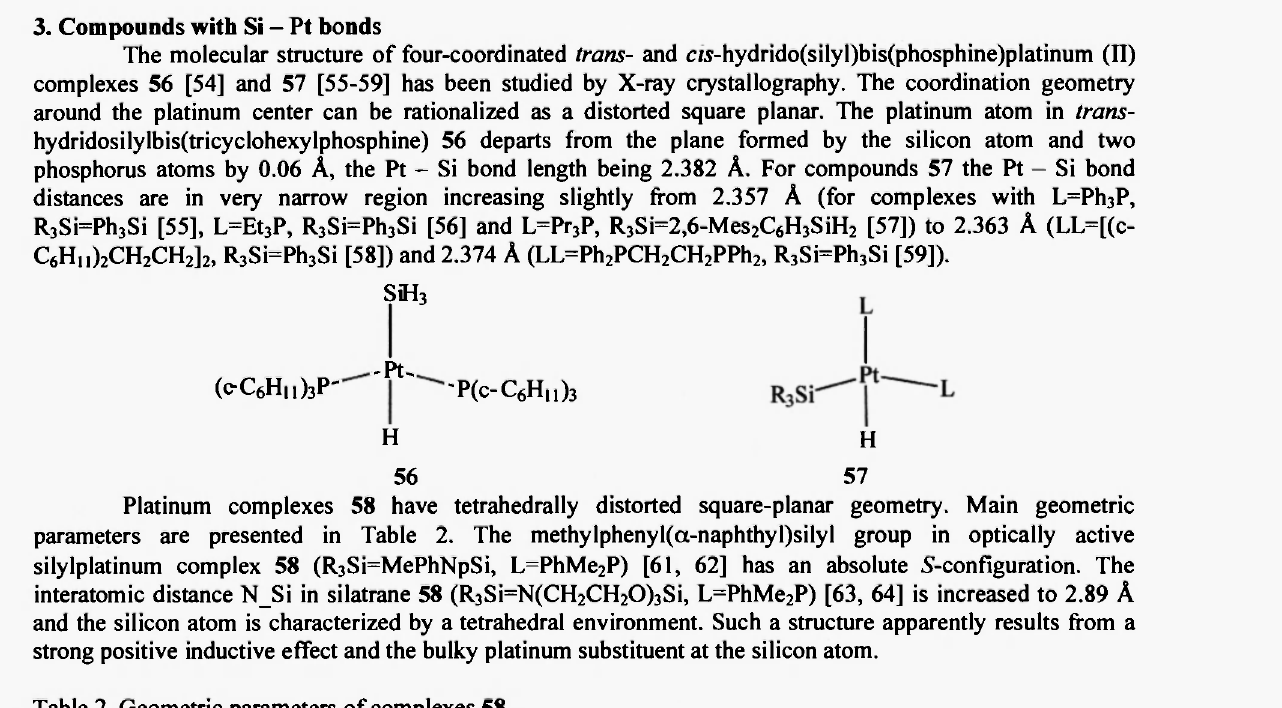
Table 2. Geometric parameters of complexes 58 R 3